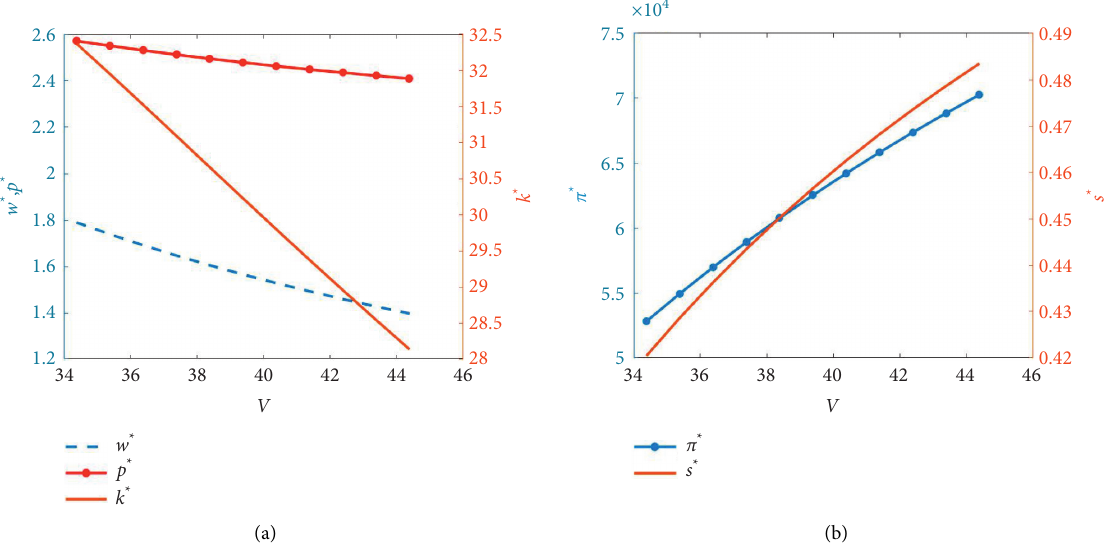
Figure 6: Sensitivity analysis of endogenous variables in terms of V . (a) p ∗ , w ∗ , and k ∗ . (b) s ∗ .